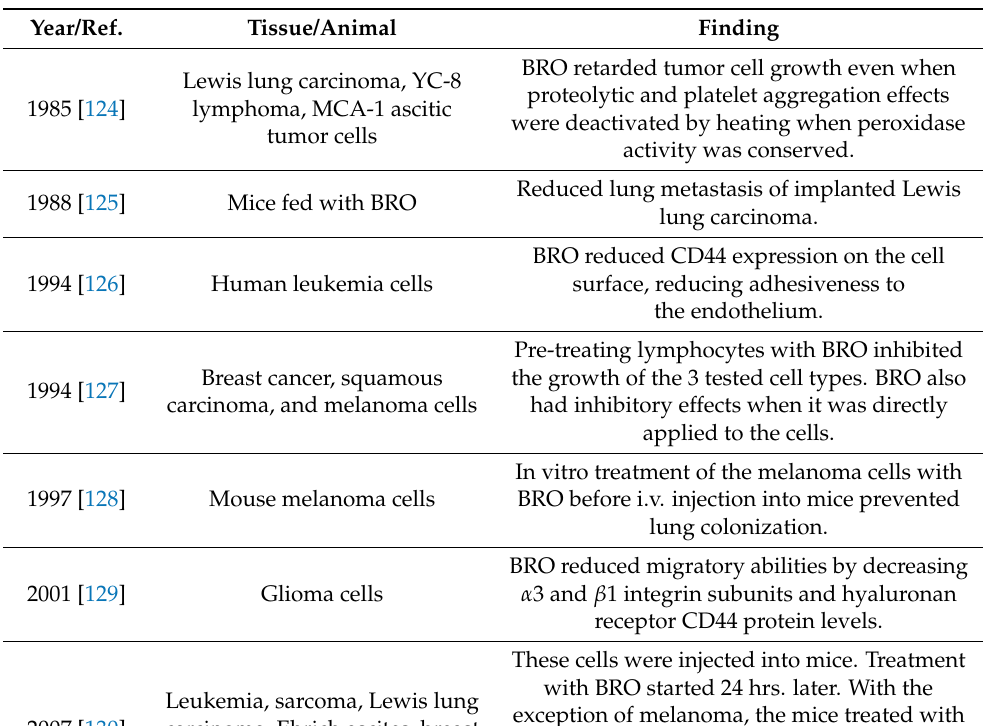
Table 2. Experience with bromelain in